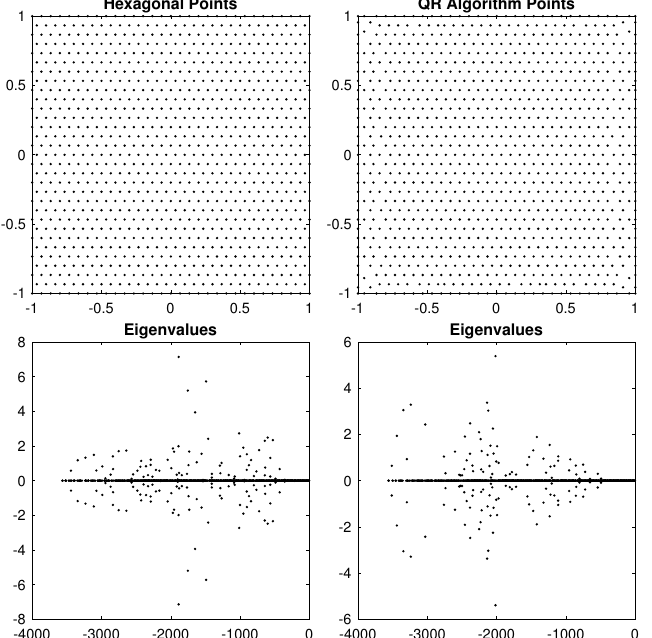
Figure 11. Hexagonal points and resulting MCpQR algorithm points with Dirichlet Laplacian